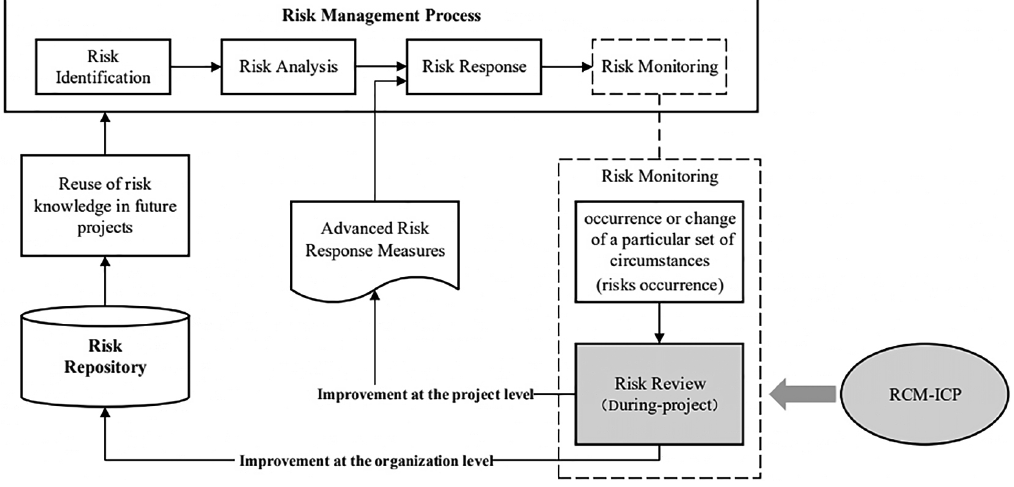
Figure 2. Risk management